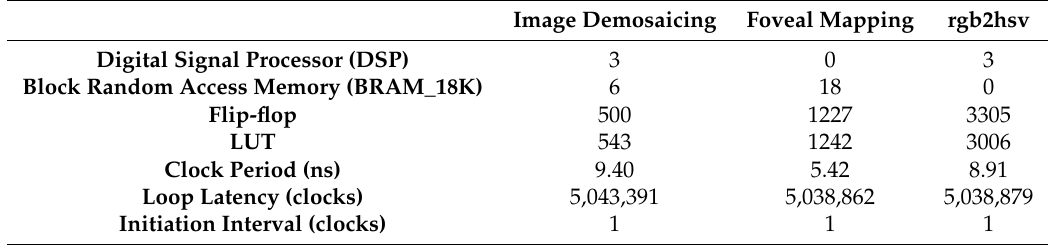
Table 1. Estimated system resources and performance as reported by the synthesis tool (the max image size is 2592 × 1944 pixels, and the target clock period is 10